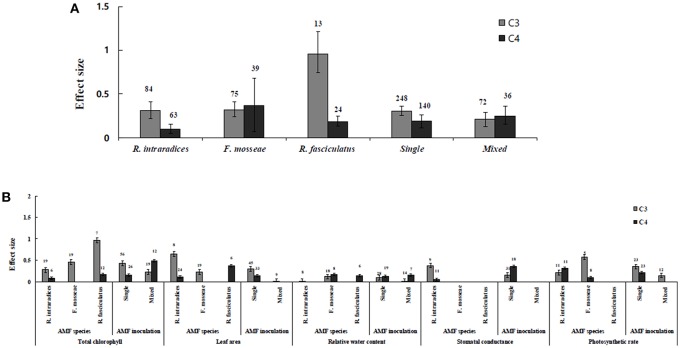
AMF species-categorical analysis. (A) Overall AMF species and AMF inoculation response to gas exchange and water status. (B) Response variables reaction to AMF species and AMF inoculation. Error bars are means ± BS CIs. Where the CIs do not overlap each other, the effect size for a parameter is significant at P < 0.05. The number of trials included in the meta-analysis is denoted above the bar.